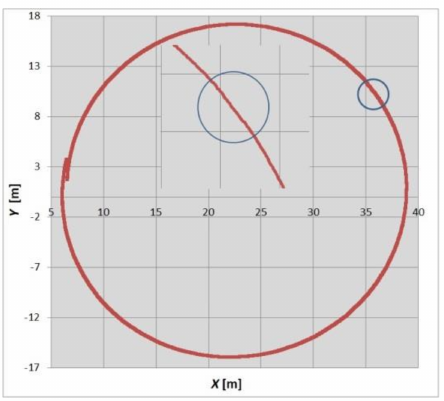
Figure 9. Change of the trajectory caused by resetting the rocker arm clearance while driving on a circular track (driving at a speed of ~30 km/h within a radius of ~22 m).